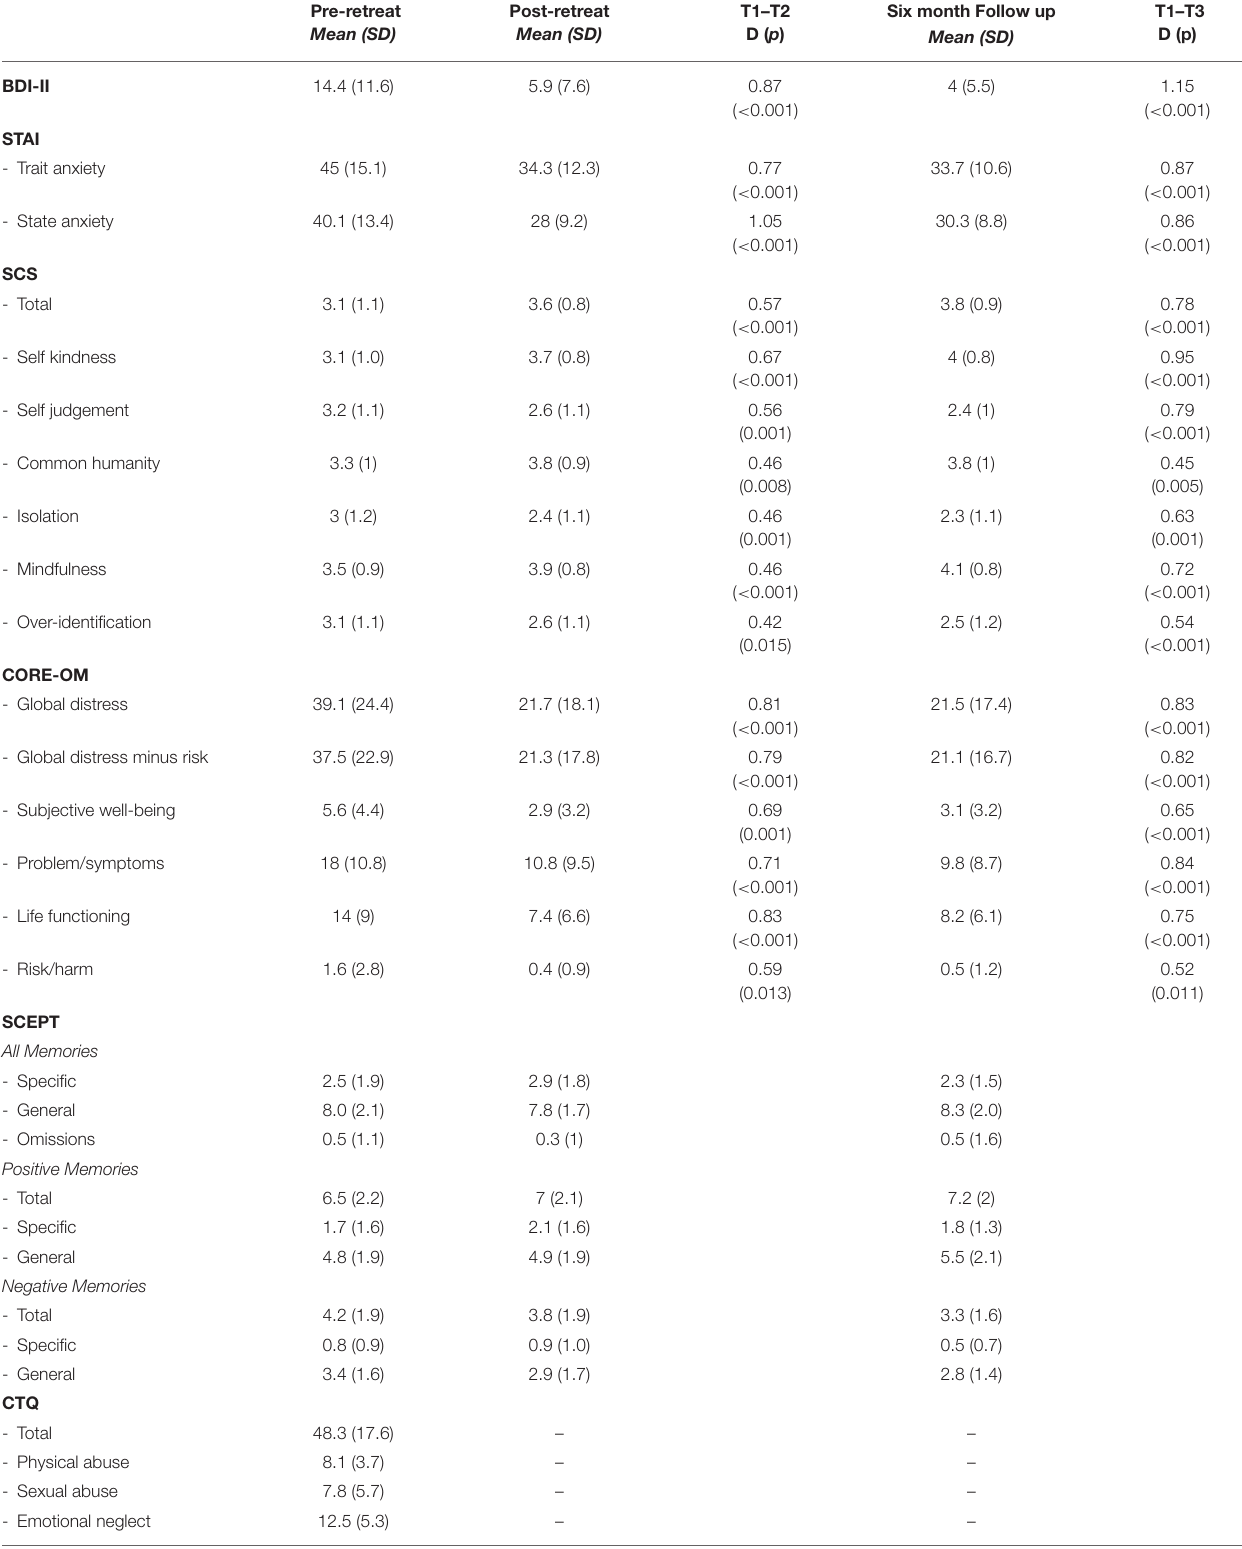
TABLE 3 | Summary of means and standard deviations for all scales and